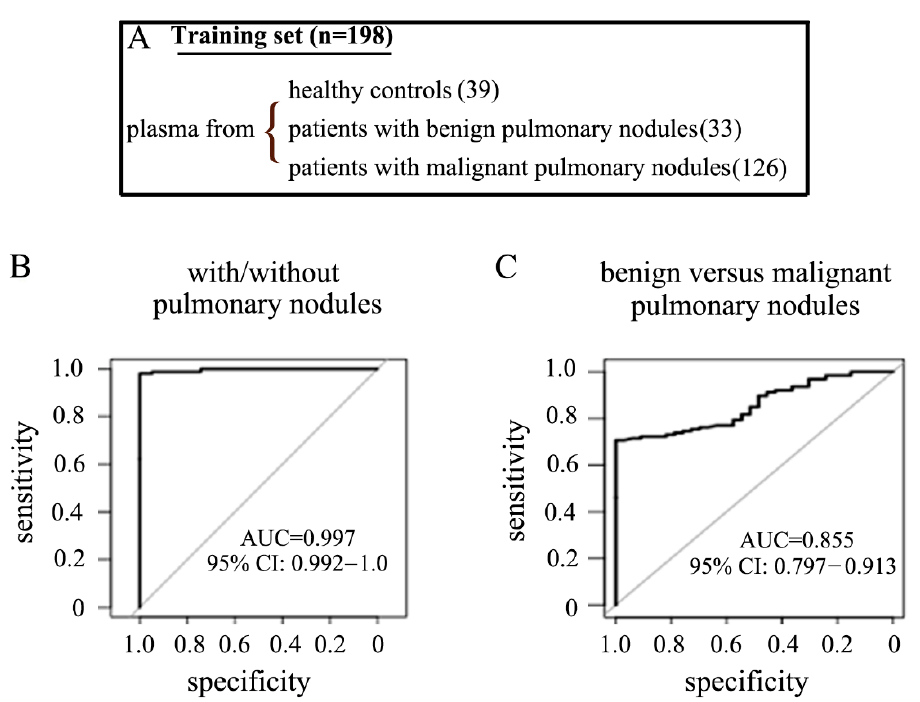
Figure 2. Assay performance in detecting both the existence and the nature of pulmonary nodules